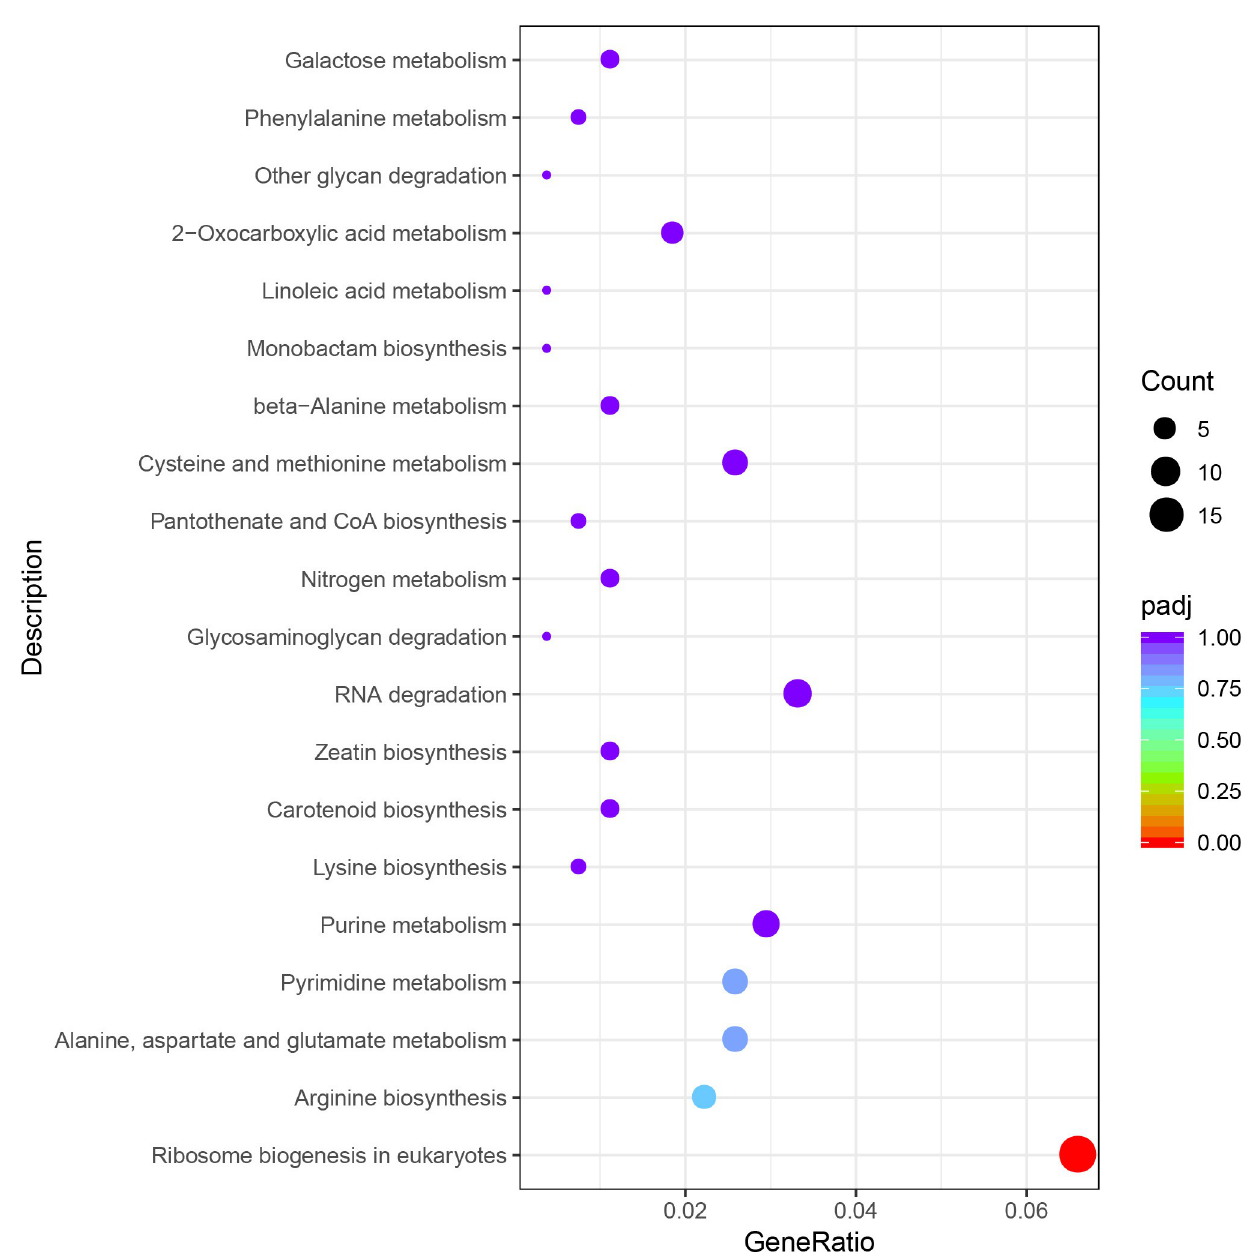
Fig 7. Enrichment bubble diagram of differential gene